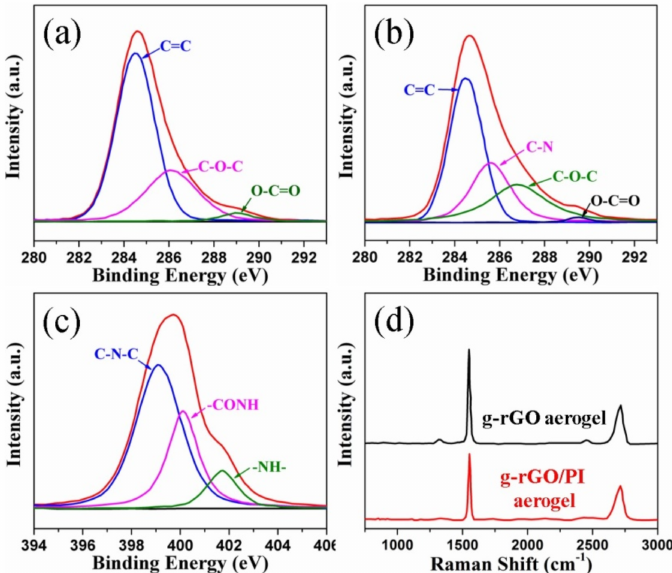
Figure 5. X-ray photoelectron spectroscopy (XPS) C1s spectra of ( a ) rGO aerogel and ( b ) rGO/PAA aerogel; ( c ) XPS N1s spectra of rGO/PI aerogel; ( d ) Raman spectra of g-rGO aerogel and g- rGO/PI